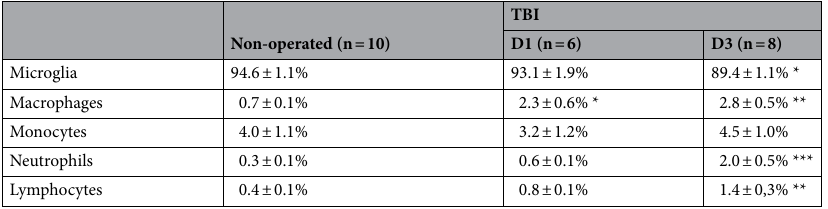
Table 1. Immune cells distribution in the CNS in non-operated mice and at one and three days after TBI. Data were expressed as mean percentage of the total immune cell population ± S.E.M. Differences were analyzed using a one-way ANOVA followed by a Dunnett’s test. * P < 0.05, ** P < 0.01 and *** P < 0.001 versus